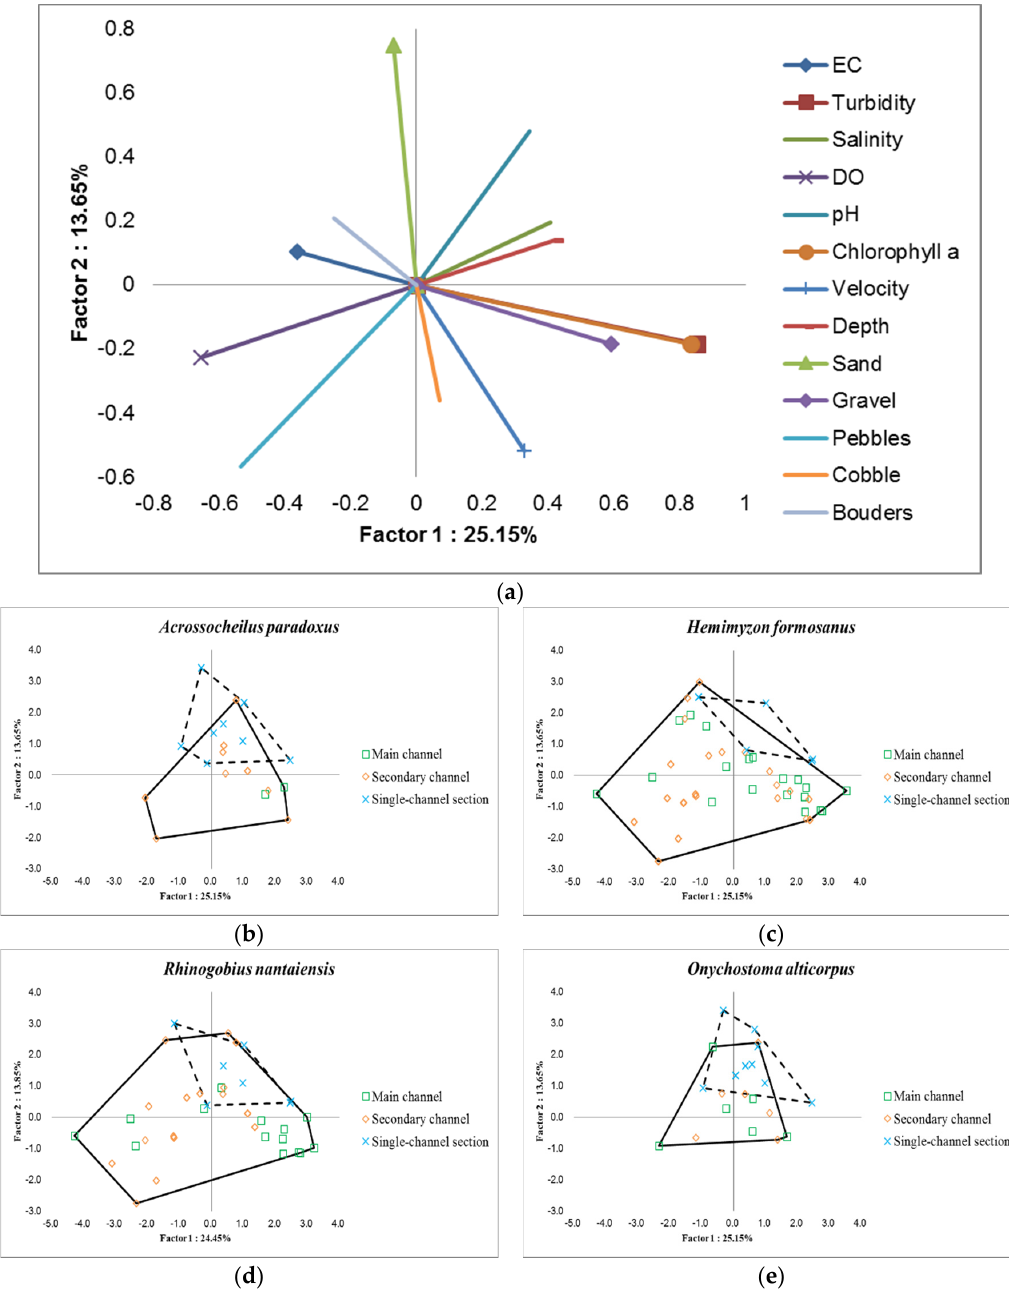
Figure 3. Thirteen environmental factors and four species in the first two principal component analysis axes. The full line is the range of the fish species in the multiple-channel section, and the dotted line is the range of the fish species in the single-channel section. ( a ) The distributions of thirteen environmental factors in the PCA diagram; ( b ) The preferred environments of Acrossocheilus paradoxus in the multiple- and single-channel sections; ( c ) The preferred environments of Hemimyzon formosanus in the multiple- and single-channel sections; ( d ) The preferred environments of Rhinogobius nantaiensis in the multiple- and single-channel sections; ( e ) The preferred environments of Onychostoma alticorpus in the multiple- and single-channel sections The logistic regression indicates which environmental factors have the most influence on fish species (Table 3). No environmental factors were found to affect the existence of the majority of fish species in the single-channel section, with the exception of R. nantaiensis . Oppositely, no